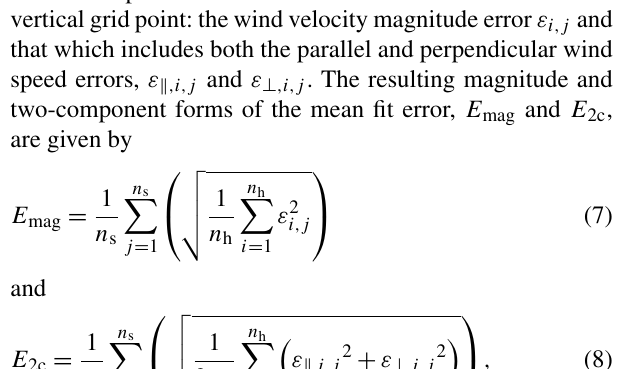
root mean square of the errors at each vertical grid point.